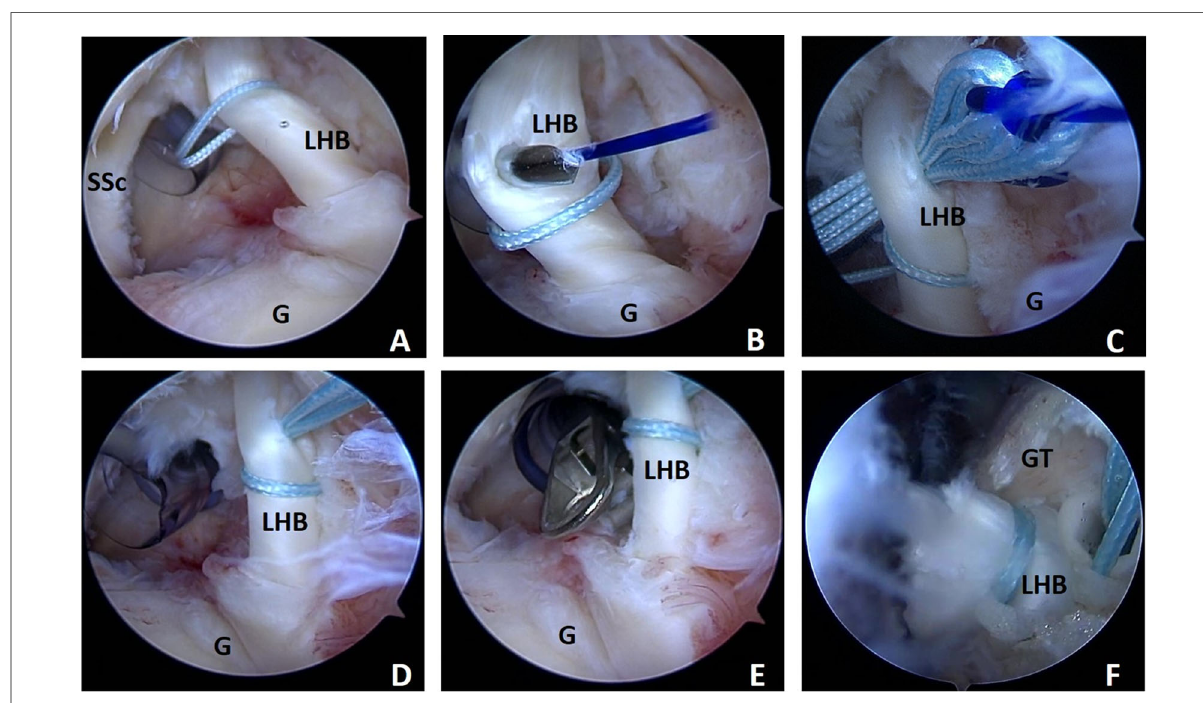
FIGURE 2 Demonstration of the high resistance loop (H-Loop) stich technique arthroscopic surgical in shoulder as viewed from the posterior portal with the patient in the lateral decubitus position using a 30° scope. ( A ) a 2# Fiber Wire suture (Arthrex, Naples, FL) was folded in half and inserted into glenohumeral joint and construct a loop hitching around the LHBT; ( B ) A Suture Lasso is pierced through the midportion of the LHBT just distal of the loop to advance a 0# PDS II Suture, as a guiding suture. ( C ) The two ends of Fiberwire suture were brought into midportion of the LHBT just distal of the loop with PDS suture; ( D ) A novel, self-locking, high-resistant rip-stop loop con fi guration was constructed; ( E ) The origin of LHBT was detached with a curved arthroscopic scissor. ( F ) The two free ends of the suture were pressed into the guide hole with a push lock anchor suture (Arthrex, Naples, FL) at the intertubercular